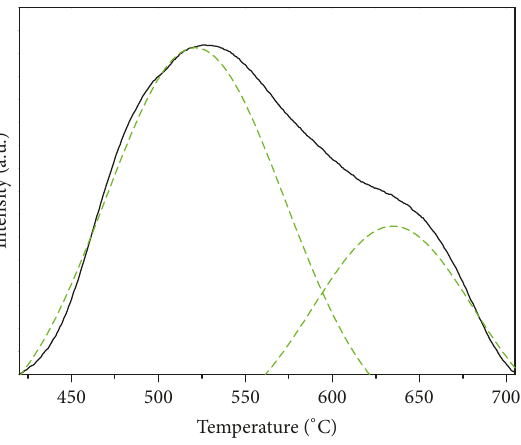
Figure 5: CO 2 -TPD profile for Pd/C-OH −